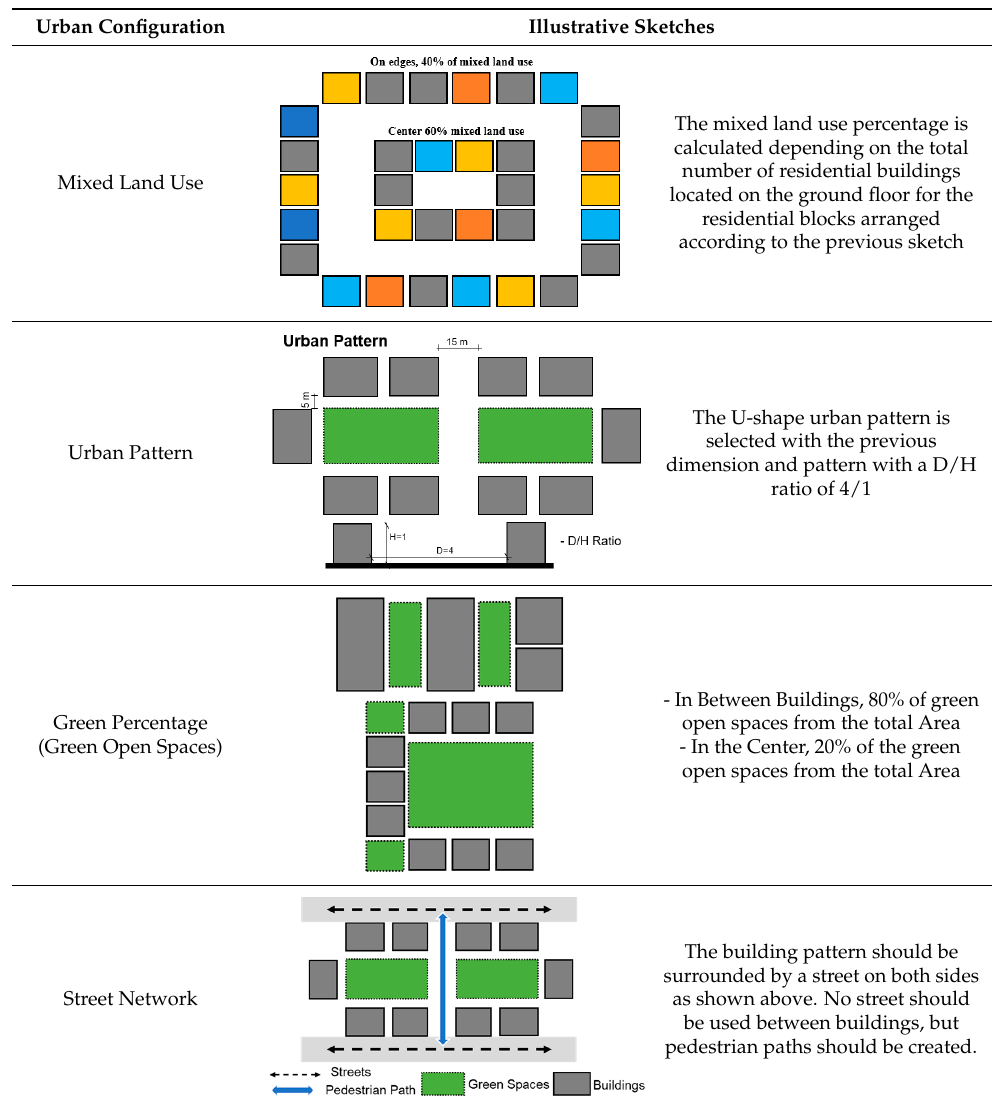
Table 3. Urban Configurations that have effects on Social Sustainability.